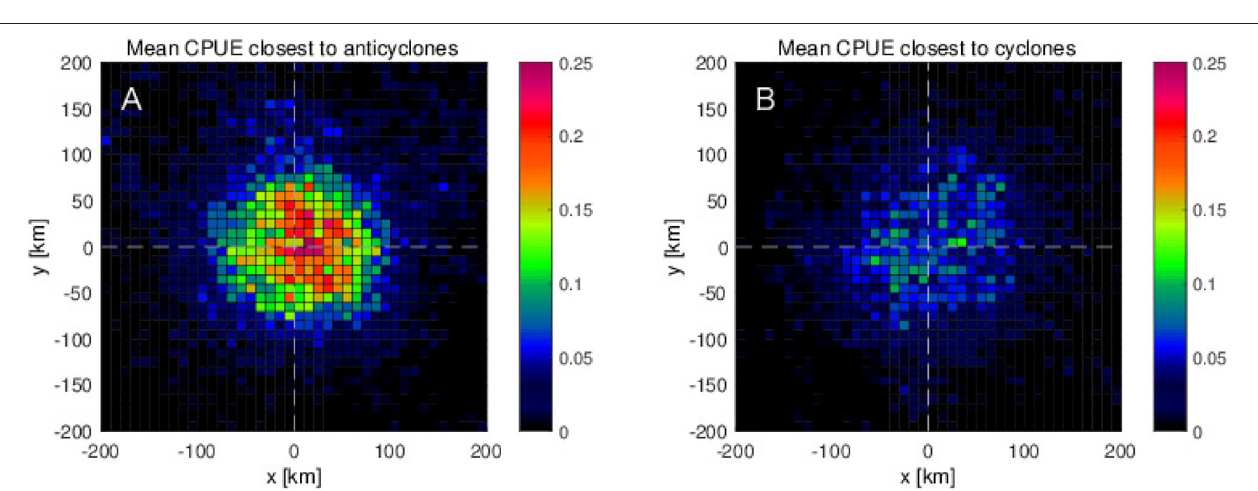
( Figures 10 , 11 ). What is more, in the southern region, the peak of CPUE formed on the northeastern side of the anticyclonic warm-core eddies found in the northern region disappears ( Figures 10A , 11A